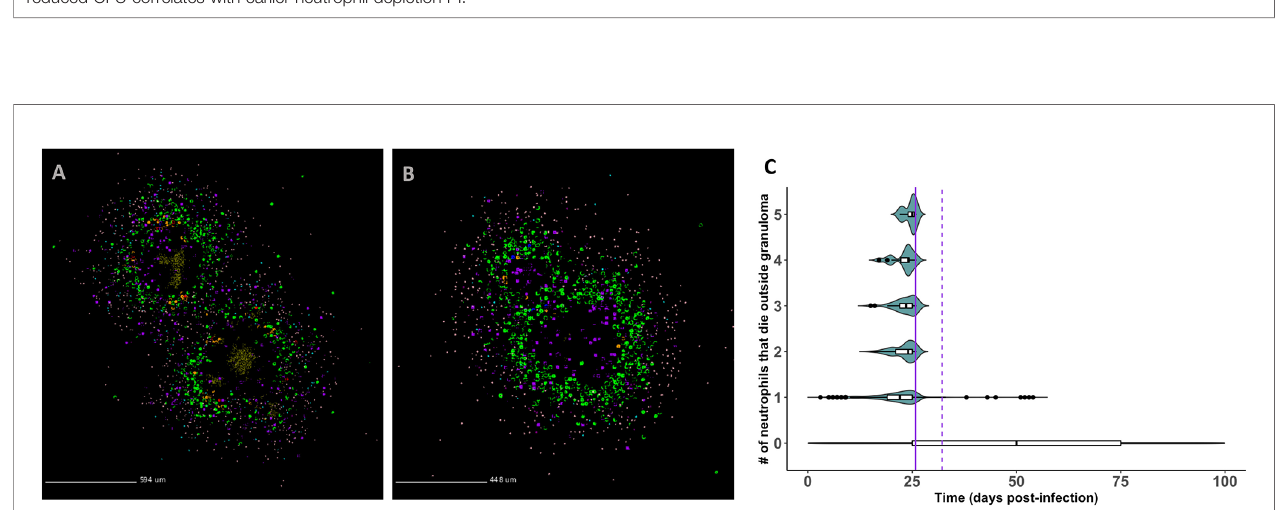
FIGURE 7 | GranSim predicts that neutrophils contribute to mycobacterial dissemination and granuloma budding. (A) A granuloma that has disseminated, resulting in two granulomas by day 200 PI. (B) A granuloma with budding, also shown at day 200 PI. We identi fi ed granulomas in panels (A, B) from the full parameter set (see Table 2 ). Macrophages (green – resting, orange – infected, red – chronically infected, blue – activated), Neutrophils (purple), T cells (Tgam – pink, Tcyt – maroon, Treg – cyan), extracellular Mtb (brown). Caseum is not shown in order to better visualize spatial locations of different cell types. (C) Frequency of neutrophil-facilitated dissemination events over time. We visualize data for all runs in the neutrophil-speci fi c parameter set. The purple vertical lines denote the start of the adaptive response (solid = T cell recruitment begins, dotted = T cell recruitment is fully ramped